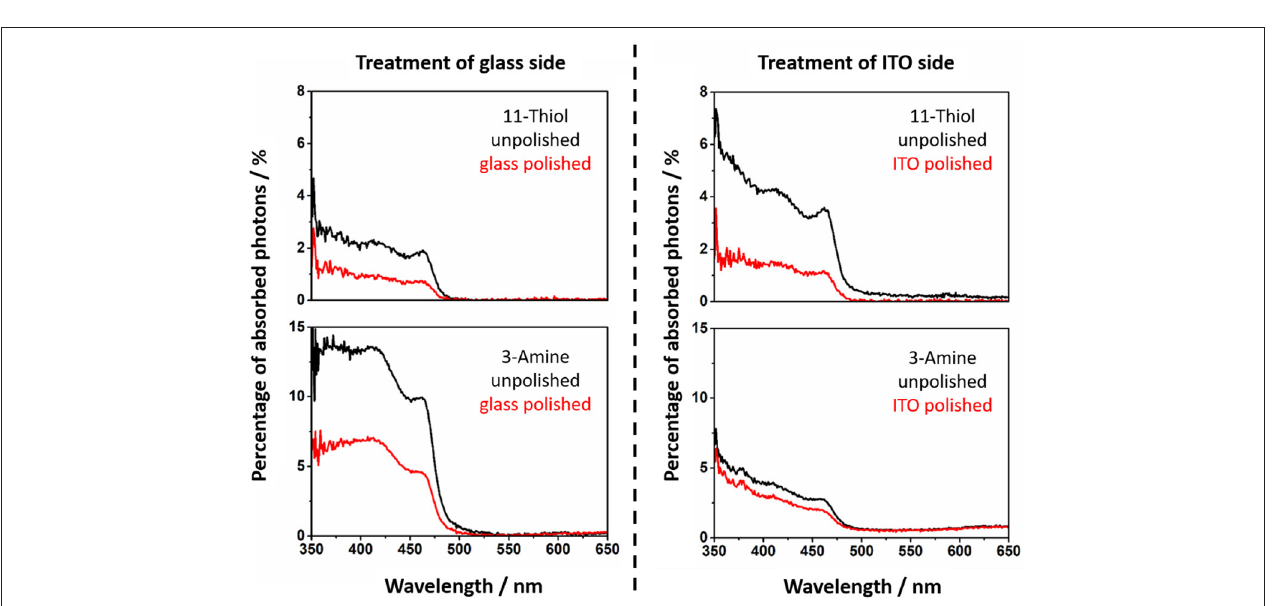
FIGURE 5 | The absorption of NRs at 11-thiol and 3-amine functionalized substrates is shown. The spectra of unpolished slides are presented (black). The absorption of polished slides are red.